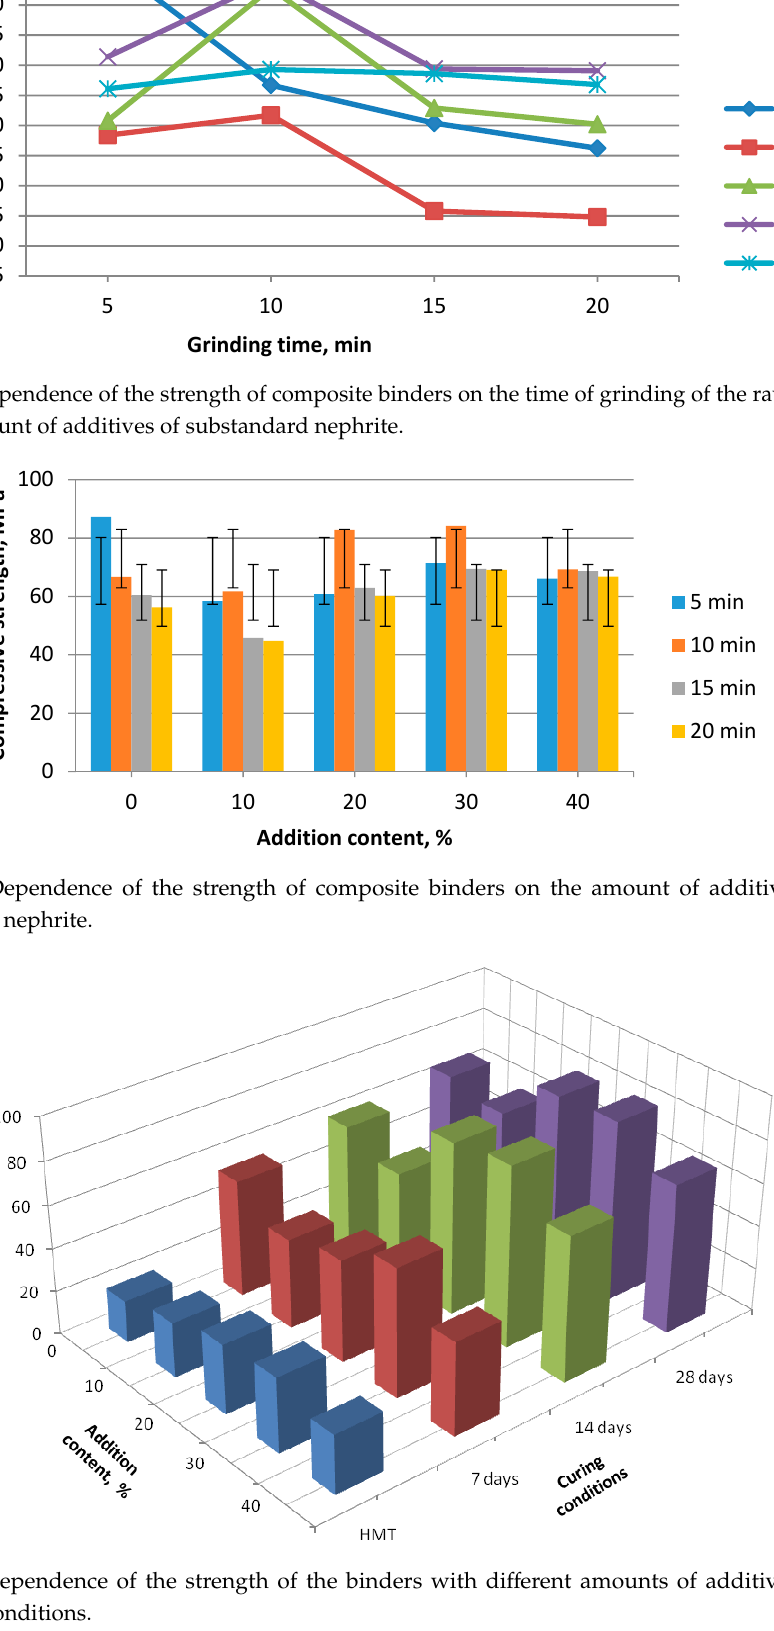
Figure 5. Dependence of the strength of the binders with different amounts of additives on the hardening conditions.